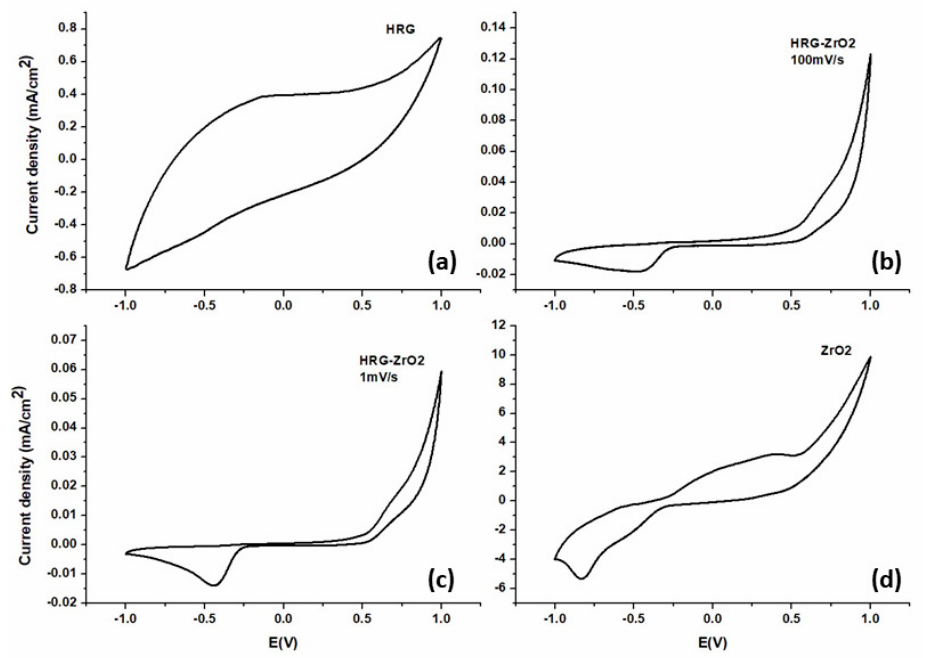
Figure 9. Cyclic voltammogram of ZrO 2 and HRG@ZrO 2 nanocomposite with different sweep rate ( a )